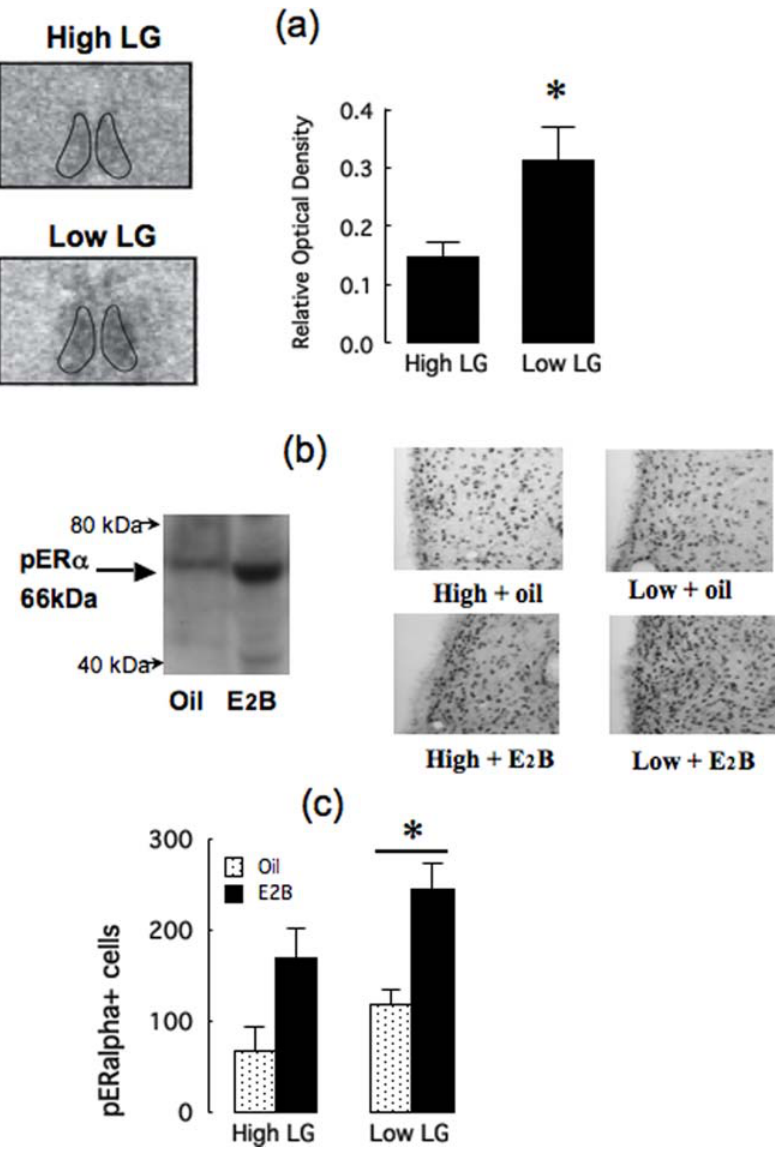
Figure 4. PhosphoER a mRNA and immunoreactivity in intact and estrogen-treated females. (a) Left panel shows representative autoradiograms of ER a mRNA expression in the anteroventral paraventricular nucleus of the hypothalamus (AVPVn; outlined region) in the adult female offspring of High or Low LG mothers. The right panel shows the mean 6 SEM for the quantification (relative optical density) of ER a mRNA in the AVPVn from the adult offspring of High or Low LG mothers (n=5/group). * p , 0.05. (b) Representative western blot depicting phosphoER a immunoreactivity at the expected 66kDa band in ovariectomized (O) treated with oil or 10 m g E2B, 90 min prior to tissue sampling. The Western blots revealed a limited banding pattern and the expected increase in phosphoER a 2 labelling. The right panels depict representative phosphoER a 2 label- ling at the level of the AVPVn in ovariectomized adult female offspring of High or Low (n=5–6/group) provided with low-level E2B replacement and then treated acutely with 10 m g of E2B or oil, 90 min prior to tissue sampling. (c) Mean 6 SEM number of phosphoER a 2 labeled cells in the AVPVn of the animals described above. Statistical analysis revealed a significant (p , 0.05) overall effect of maternal care such that the number of phosphoER a 2 labeled cells was increased in the offspring of Low LG mothers in both treatment conditions.